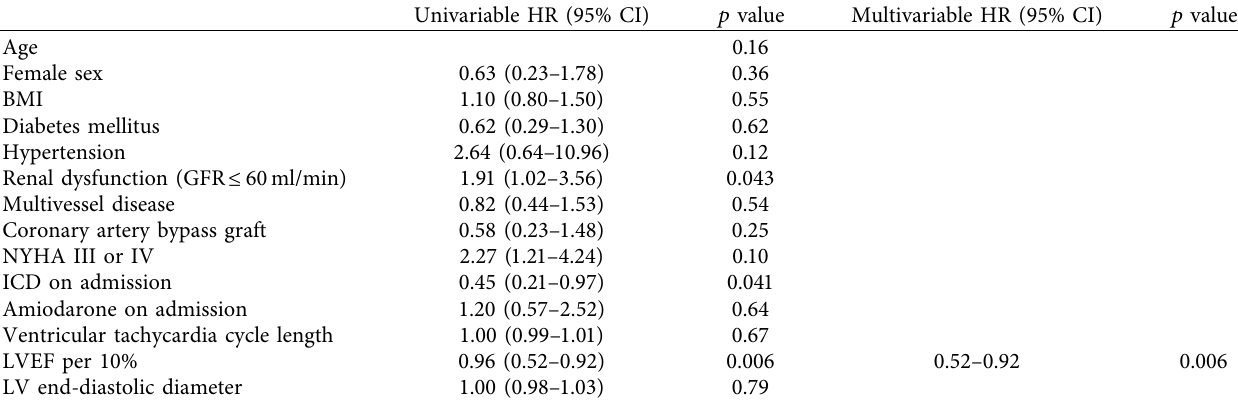
Table 3: Outcome predictors non-CTO patients.